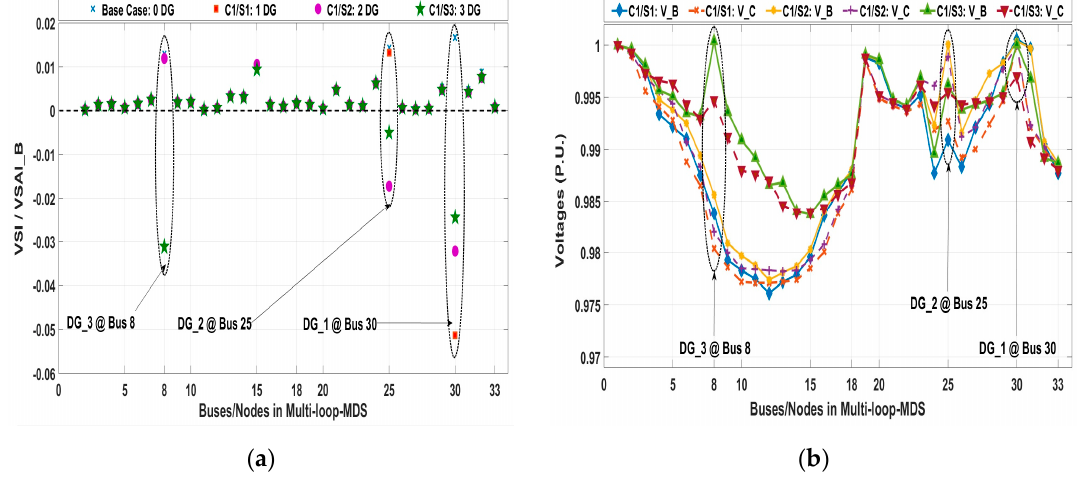
Figure 6. Case 1 for 33-bus MDS: All DGs are type-1 and operating at unity PF ( a ) VSAI_B trend, ( b ) V_B profile trend as feasible solution of VSAI_B and calculated V_C profiles.